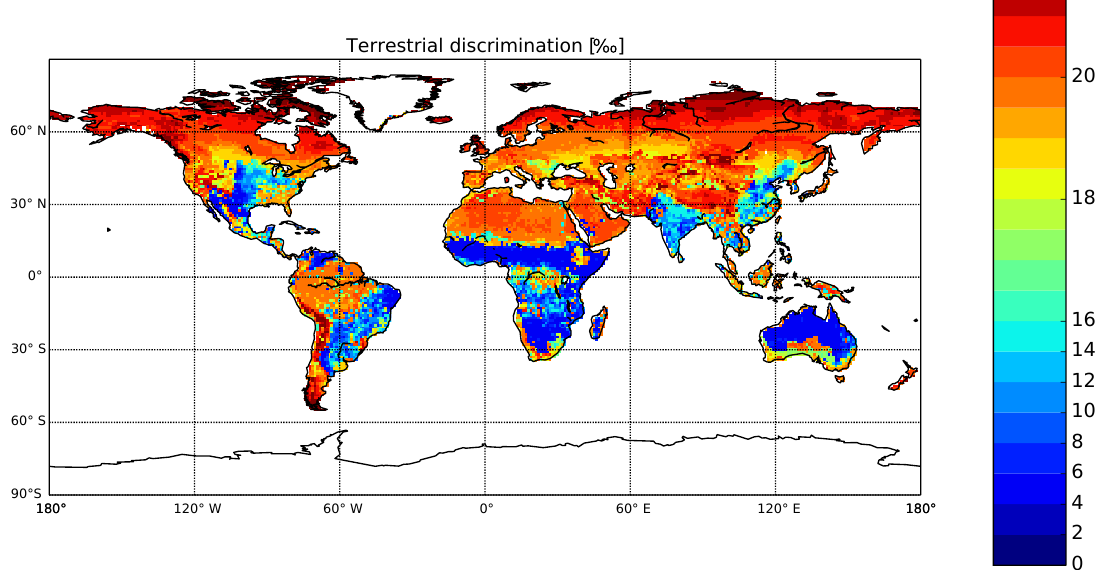
Figure 4. Mean (2001–2011) modeled discrimination parameter (cid:49) ph (‰) from SiBCASA. The discrimination is more detailed for (cid:49) ph > 16‰ to highlight the more subtle variations in (cid:49) ph in the dominant C 3 regions that experience different environmental forcing.